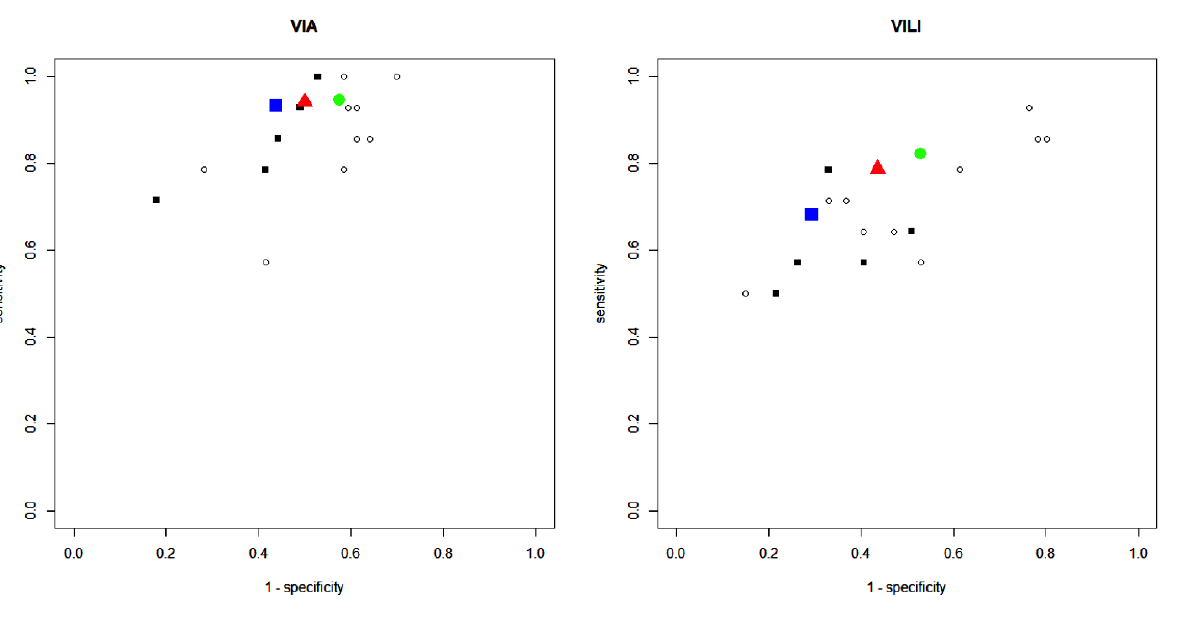
Figure 3. Sensitivity and specificity of digital visual inspection with acetic acid (D-VIA) and Lugol’s iodine (D-VILI) for all raters (red triangle), experts (blue square), and novices (green